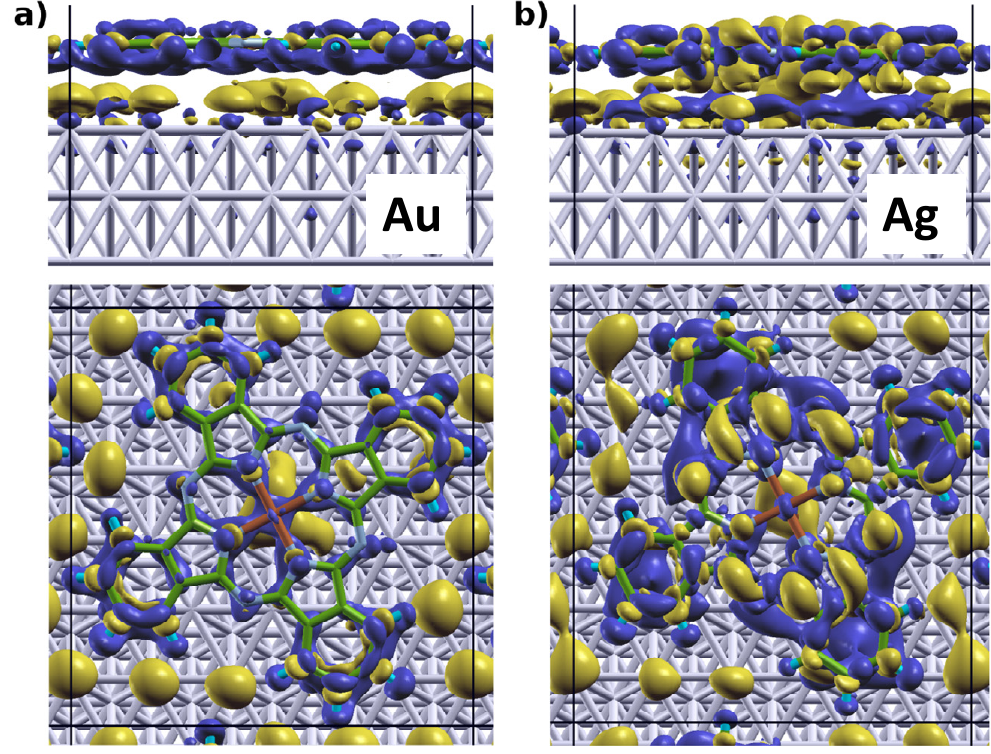
Figure 4. 3D-represantation of charge rearrangements occurring due to adsorption of CuPc on Au(111) ( a ) and Ag(111) ( b ) calculated using the HSE06 functional. Blue regions indicate electron depletion, while yellow regions indicate electron accumulation.